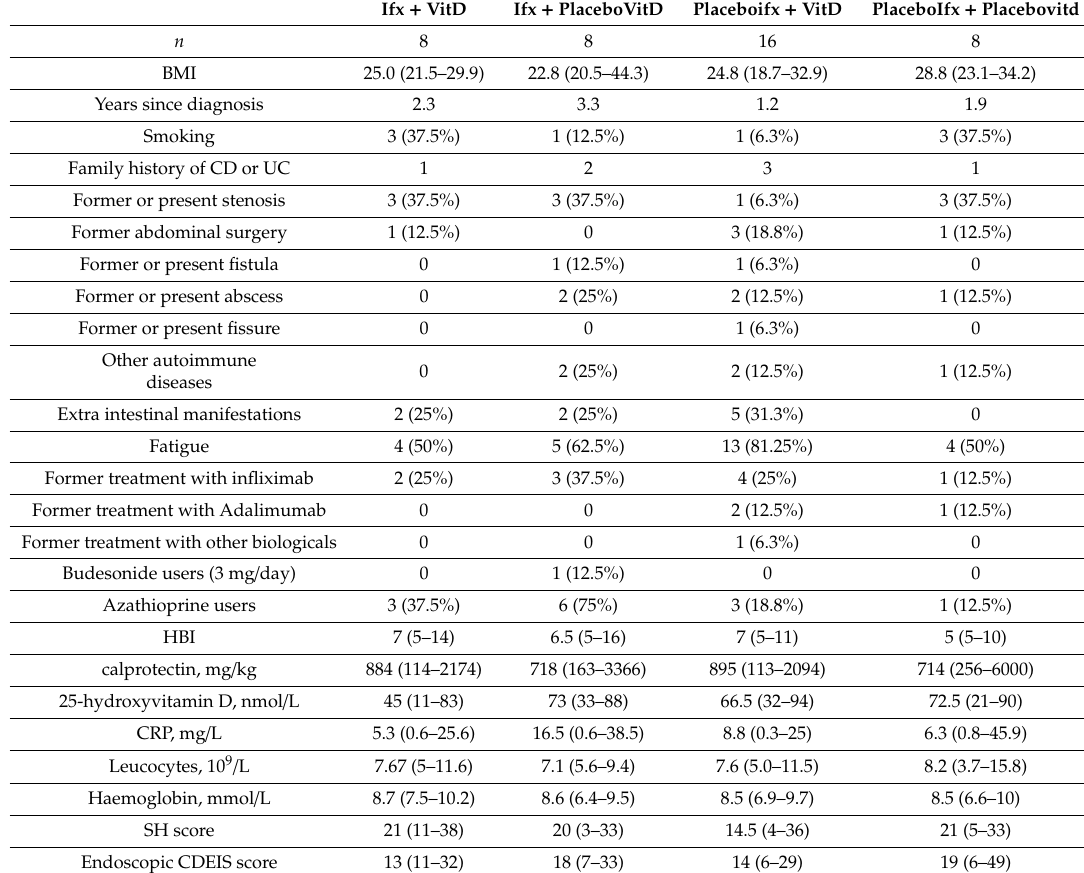
Table 1. Baseline patient